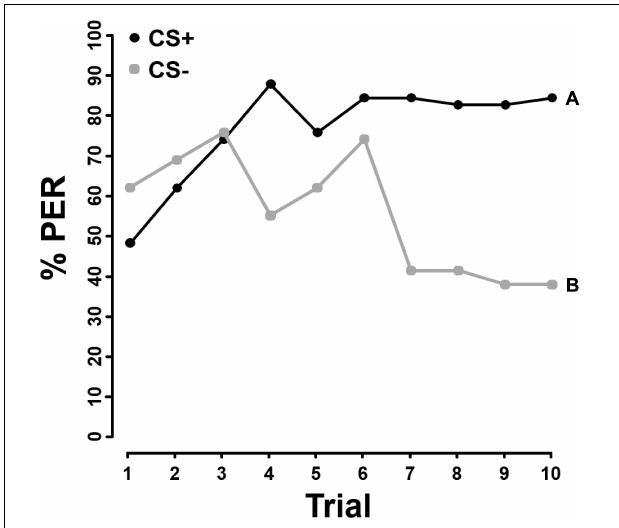
FIGURE 4 | Percentage of proboscis extension responses (% PER) shown by Apis mellifera individuals ( N = 30) in differential chemotactile conditioning to sterols added to pollen in 10x their natural concentration and dissolved in chloroform (10x SC) against pure chloroform over 10 trials. CS+ (black) represents the rewarded conditioned stimulus, CS– (gray) the unrewarded conditioned stimulus. Both, 10x SC and chloroform were used as CS+ and CS–. As there was no significant difference in learning performance between 10x SC and pure chloroform used as CS+ or CS– ( Supplementary Table 4 ), data from both groups were combined. Letters with an asterisk next to each line indicate no significant difference between the two stimuli ( P >